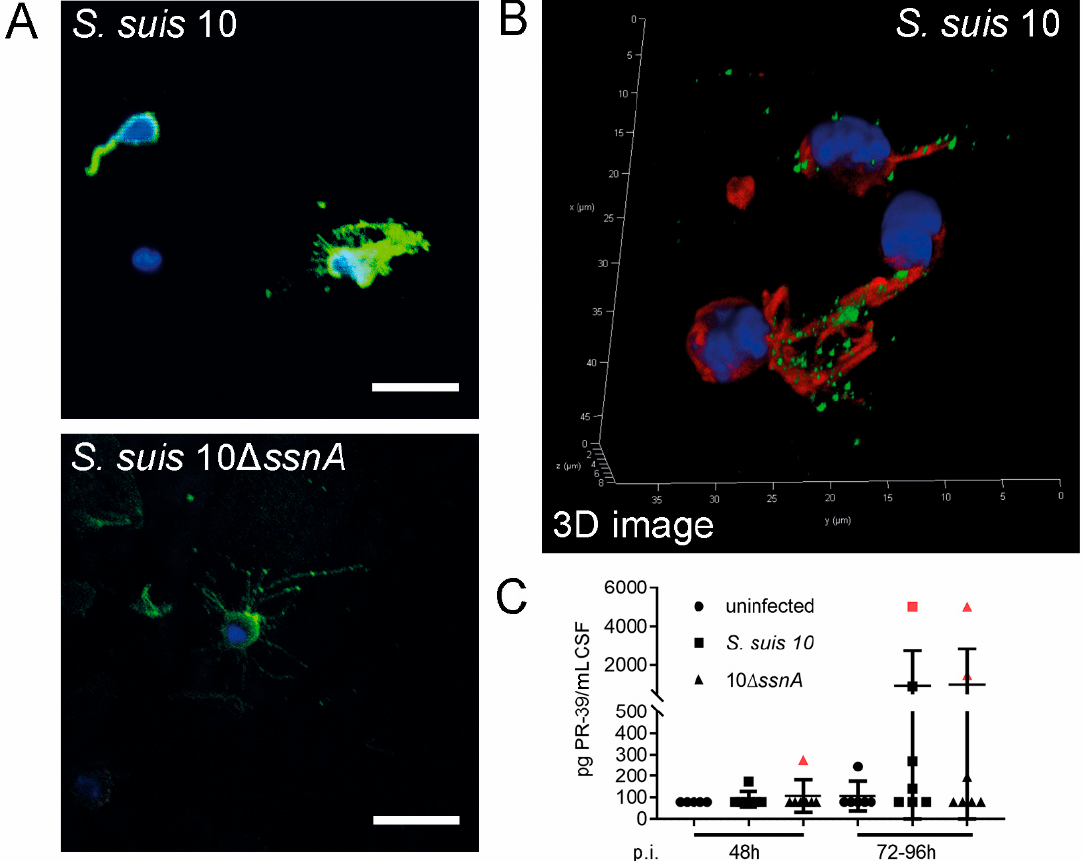
Figure 2. Neutrophil extracellular traps (NETs) are formed in the cerebrospinal fluid (CSF) of piglets infected with S. suis (strain 10) or its isogenic ssnA mutant and contain PR-39. Cytospins were conducted with CSF taken from infected piglets in the early phase experiment and were analyzed with immunofluorescence staining. ( A ) NET fibers were seen in CSF of piglets with meningitis from both infection groups (blue = DNA (Hoechst); green = DNA / histone-1-complexes (NETs)). Representative pictures are shown. ( B ) The antimicrobial peptide PR-39 is embedded in NET fibers and around the nucleus of neutrophils in CSF of infected piglets with meningitis from both infection groups. DNA / histone-1-complexes appeared to a lesser extent. The 3D image was modeled out of 50 z-stacks (0.17 µ m steps) with LAS X 3D Version 3.1.0 software from Leica. (blue = DNA (Hoechst); green = DNA / histone-1-complexes (NETs); red = PR-39). Representative pictures are shown (scale bar A = 20 µ m; B = 5 µ m). ( C ) A high amount of antimicrobial peptide PR-39 in CSF of animals with clinical meningitis (red marks) was determined by ELISA. Data shown as mean ± SD. Statistical analysis: unpaired Mann–Whitney